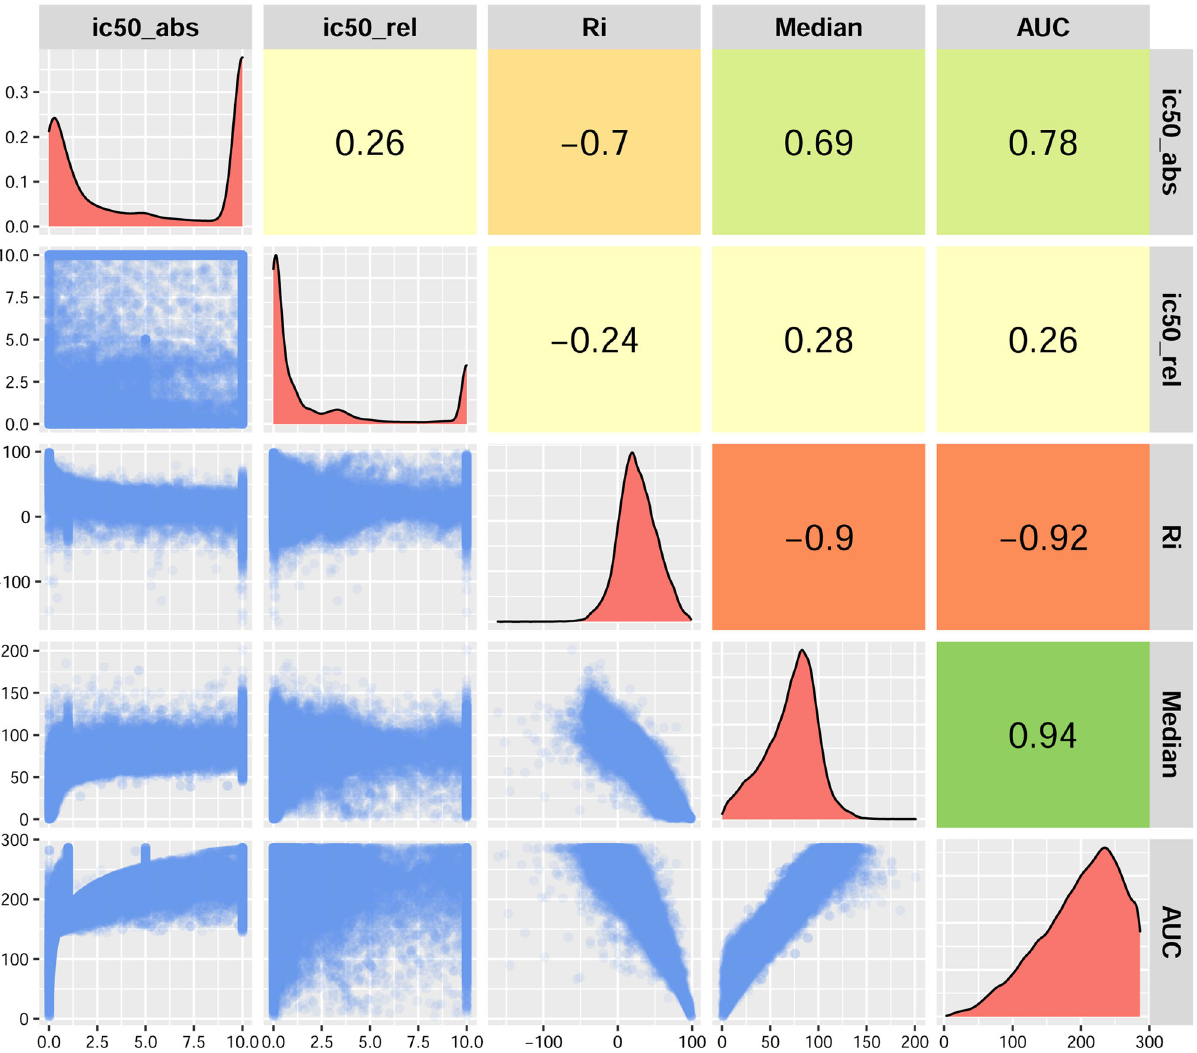
Fig. 2 Comparison of different measures for drug response experiments in the Beat AML study. The lower triangle of this pairwise comparison matrix shows the pairwise scatter plots for ic50_abs (Absolute IC50), ic50_rel (Relative IC50), RI (Relative Inhibition), median (the median of cell viability), and AUC (Area Under Curve of cell viability fi tted line). The corresponding measures in all 10 possible pairwise associations are shown on the x- and y-axis in each scatter plot. The diagonal panel describes the histogram of each measure independently. The upper triangle represents the Pearson correlation coef fi cients of the corresponding pairwise comparisons. Source data are provided as a Source Data fi